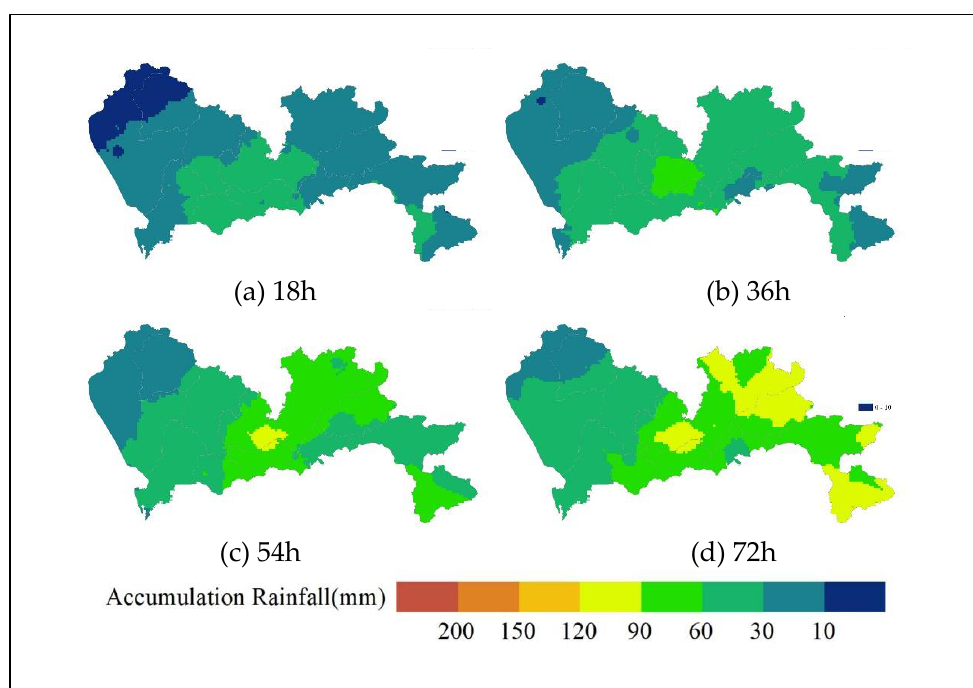
Figure 9. Rainfall accumulation of rainstorm of type II occurred on 26 August 2017.